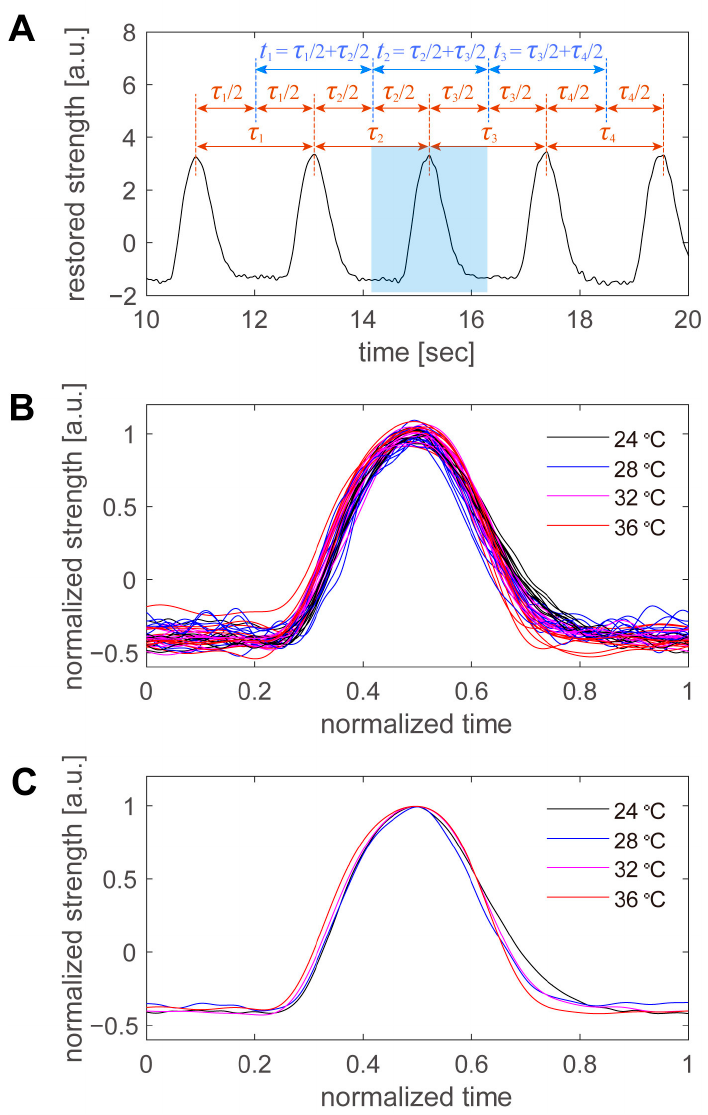
Figure 8. Comparison of the pulsating waveforms at different temperatures. ( A ) Pulsation waveform at 24 °C. A portion of the waveform in Figure 5C was removed. The period of each peak was defined by the boundary of the intermediate time between peaks. ( B ) First 10 beats at each temperature, superimposed over one another. The period of each beat is normalized and displayed. ( C ) Average of the 10 peak waveforms at each temperature.